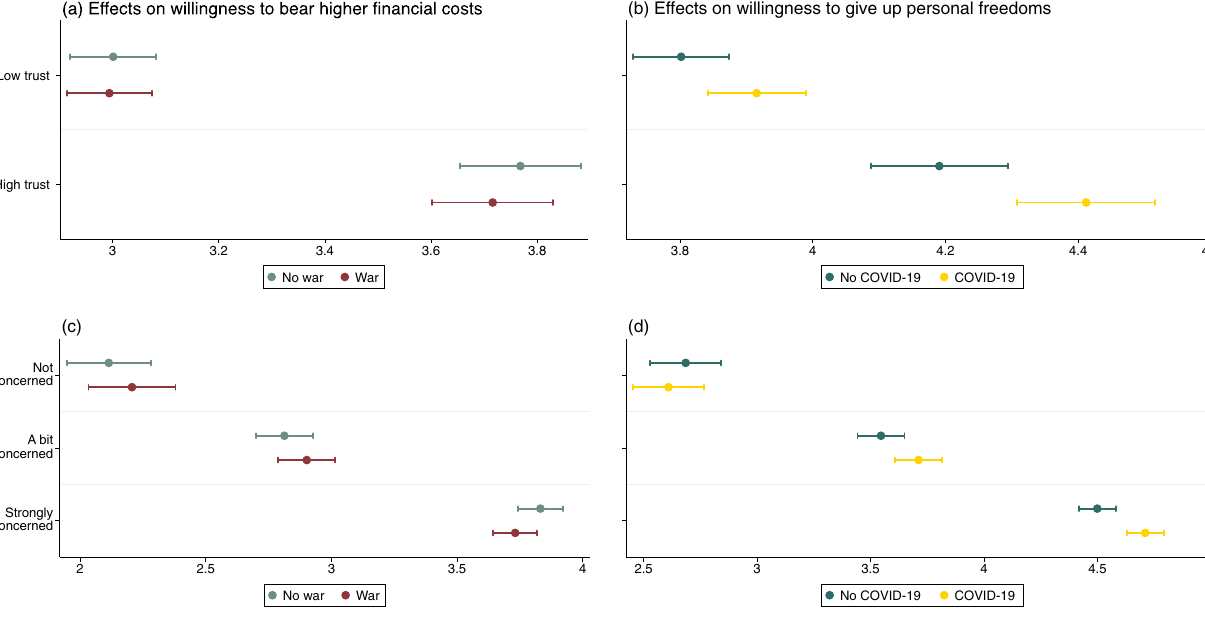
Fig. 2 Heterogenous treatment effects on type 1 and type 2 measures. Heterogenous effects are illustrated based on adjusted predictions with 95% con fi dence intervals. Relies on linear regressions with interactions of pooled treatments with ( a , b ) trust in government and ( c , d ) concern about climate change. Results are shown in Supplementary Tables 3 and 4. Results based on non-pooled treatments lead to substantively similar